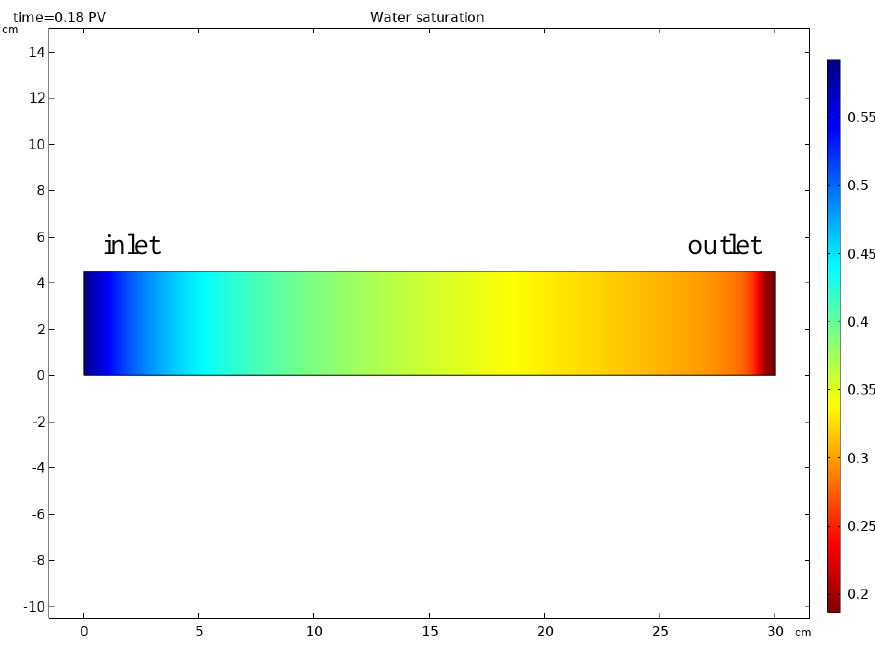
where v represents the flow rate (m/s), t is the injection time (s), φ denotes the porosity and L stands for the length of the model